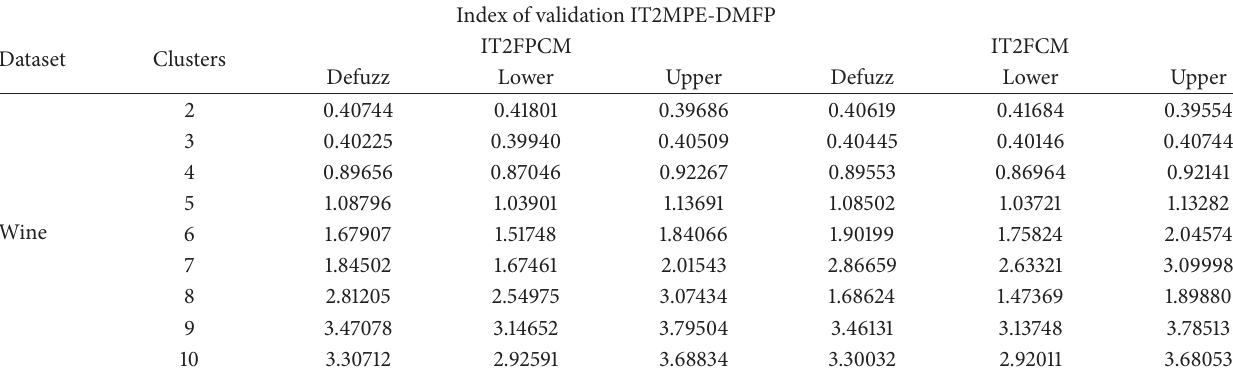
Table 5: Results of the IT2MPE-DMFP validation index to Wine dataset clustering using IT2FPCM and IT2FCM algorithm using 𝑚 = [1.5, 2] and 𝜂 = [1.5, 2.5] as